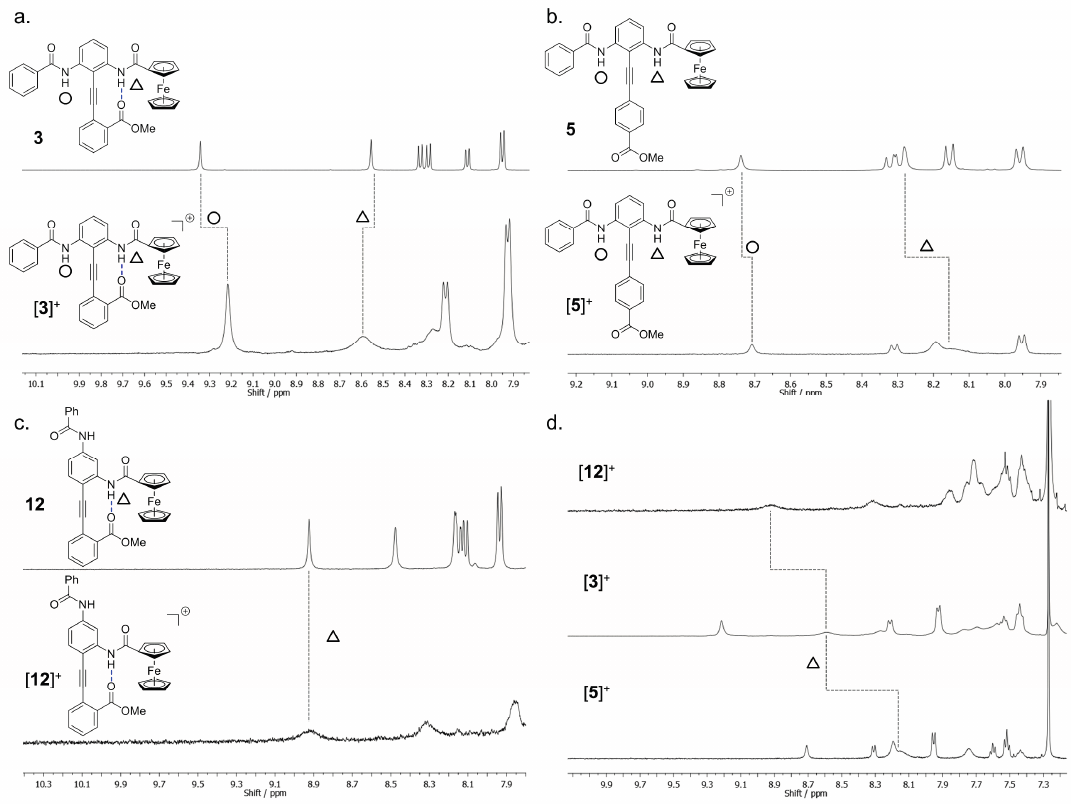
Figure 6. A comparison of the 1 H-NMR spectra of ( a ) 3 and [ 3 ] + ; ( b ) 5 and [ 5 ] + ; ( c ) 12 and [ 12 ] + ; and ( d ) the conformational analysis of [ 3 ] + (peak assignments determined by NOE and COSY